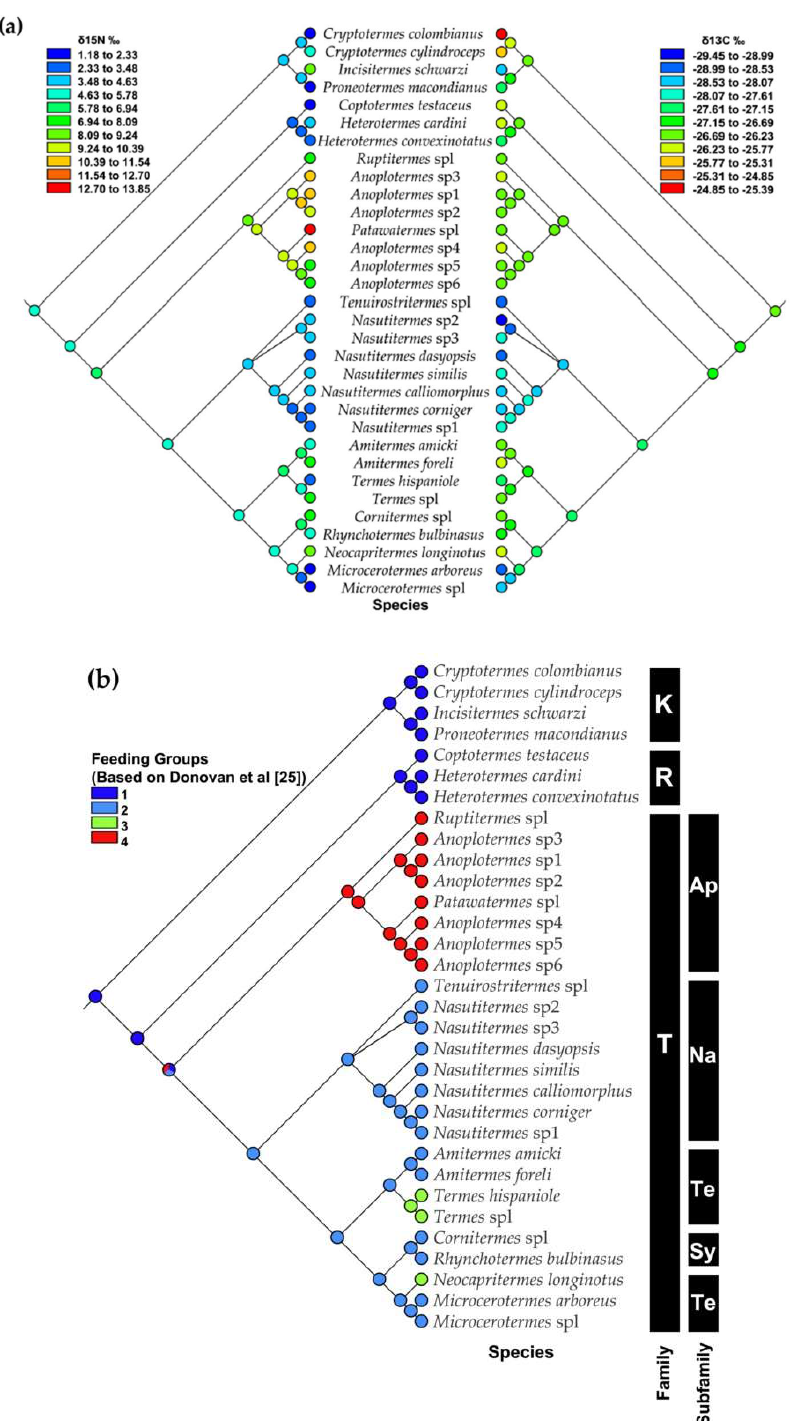
Figure 7. ( a ) Mirrored phylogenetic trees for a subset of 32 termites species, showing parsimony reconstruction of quantitative δ 15 N values from tropical dry forest termites (left-side tree) compared to quantitative δ 13 C (right-side tree), ( b ) ancestral states for categorical feeding groups based on Donovan et al. 2001 [25]; Dark blue represents feeding group I, light blue represents feeding group II (down-side tree), green represents feeding group III, and red represents feeding group IV. Ancestral states represented by colors at the nodes of the phylogeny observed at the tips are circled at each node. Families: K: Kalotermitidae, R: Rhinotermitidae, and T: Termitidae. Subfamilies: Ap: Apicotermitinae, Na: Nasutitermitinae, Te: Termitinae, and Sy: Syntermitinae.